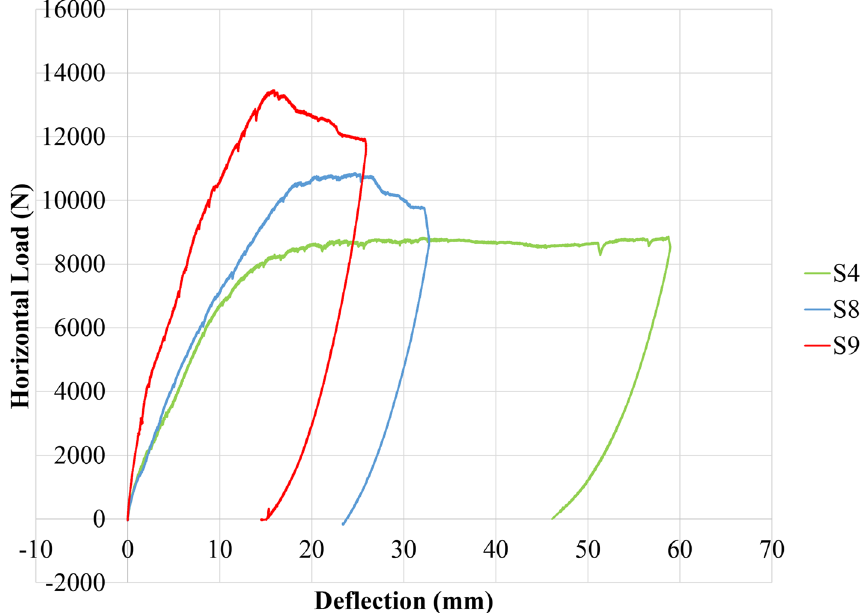
Fig. 12 Load deflection curve for specimens: S4, S8, and